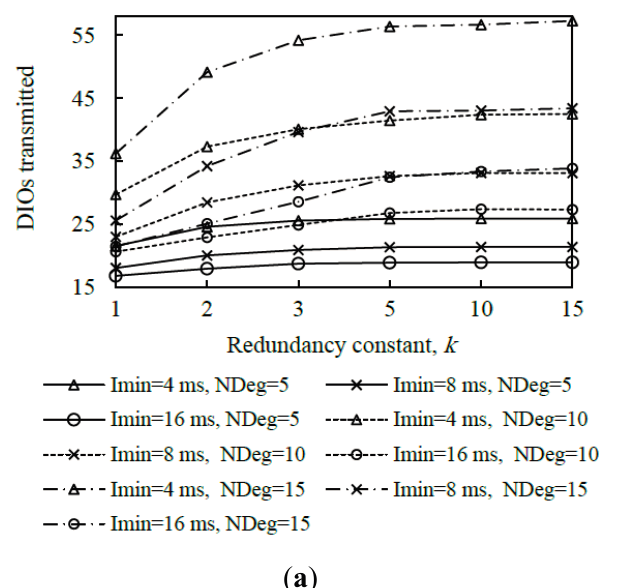
Figure 11. Average number of DIO messages transmitted and collisions in the small network scenario for different average node degrees, as a function of the redundancy constant, k , for different values of I min